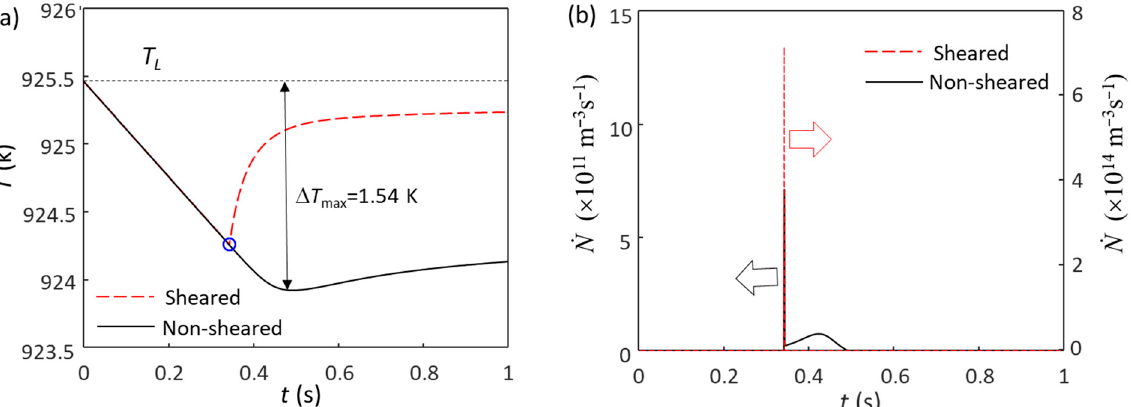
Figure 4. The calculated ( a ) cooling curves and ( b ) grain initiation rates of Mg-0.3Zr alloy without and with intensive melt shearing at a cooling rate of 3.5 K/s. The blue circle marks the onset of grain initiation induced by native MgO particles, which is also the nucleation temperature of native MgO nucleating α -Mg. The blue circle in ( a ) marks the onset of grain initiation on solid particles induced by MgO particles.